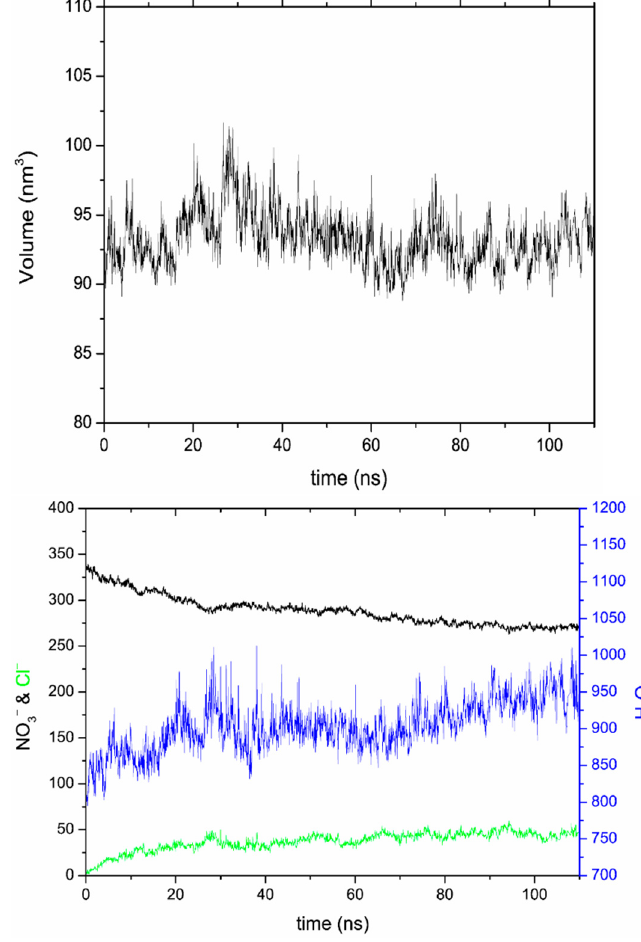
Figure 3. Volume (in nm 3 ) of the LDH-NO 3 model particle calculated with resort to the positions of the Al 3+ and Zn 2+ ions in the cationic layers in each frame of the MD simulation ( top ). The number of nitrate anions (black), chloride anions (green), and water molecules (blue) within the LDH-NO 3 interlayers ( bottom ).